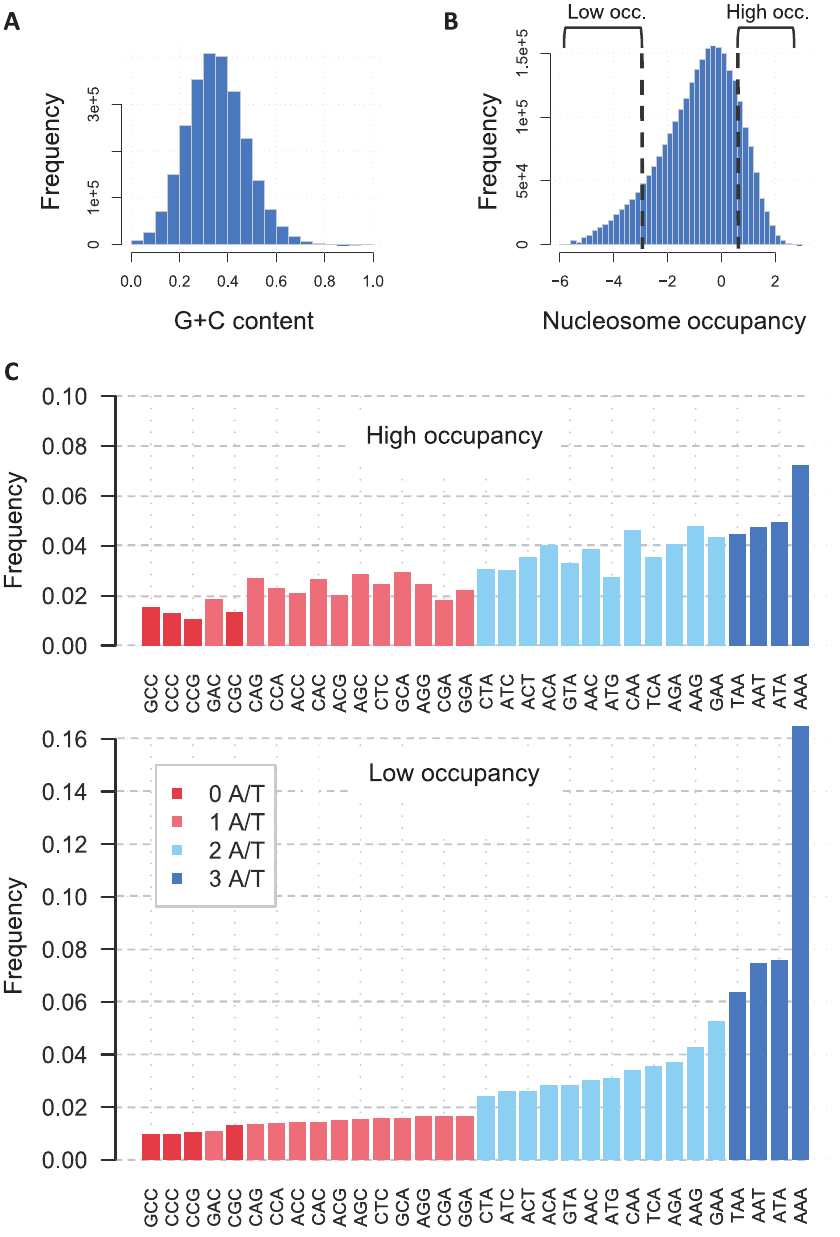
Figure 1. Yeast sequence heterogeneity is correlated with nucleosome occupancy. A) Heterogeneous local G + C content in yeast. Shown is the distribution of G + C content in small (20 bp) bins across intergenic sequences in the S. cerevisae genome (see Fig S1 for further analysis). B) Partitioning the genome into high and low occupancy sequences. Shown is the distribution of in-vivo nucleosome occupancy scores across all yeast intergenic loci (data from Kaplan et al., 2009). C) A/T trinucleotides are enriched at low occupancy loci. The frequencies of all trinucleotides in loci with high (top) and low (bottom) nucleosome occupancy are depicted. As shown before, A/T trinucleotides are in excess at low occupancy loci. Also observed is the correlation between the number of G/C nucleotides within the trinucleotide and the relative abundance of the trinucleotide in high vs low occupancy loci.